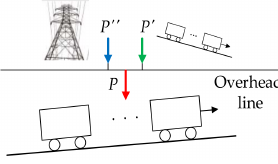
Figure 5. Power source of traction trains in a certain power supply